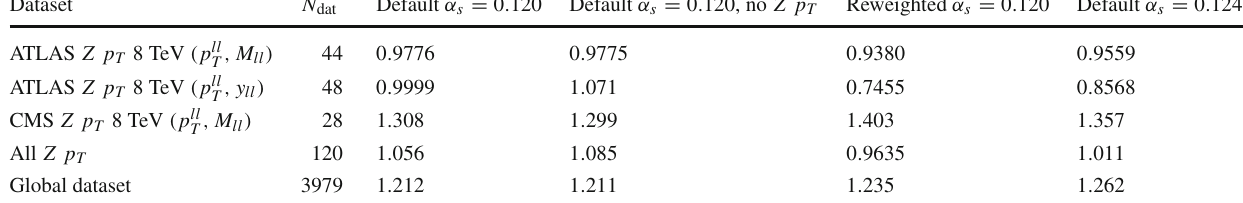
z p T are obtained by combining the three datasets listed in this table. We also include values for a global fit from which the Z p T data have